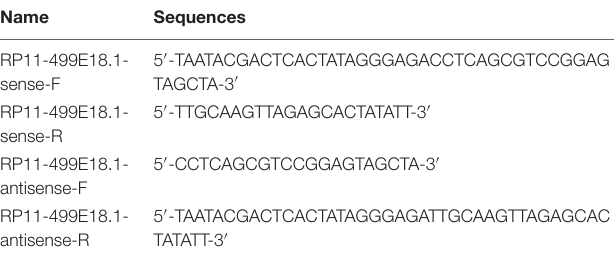
TABLE 4 | The oligonucleotide sequences used for RNA pulldown